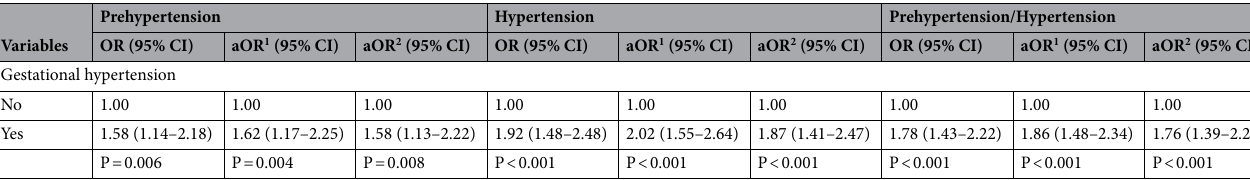
Table 2. Associations of maternal gestational hypertension with HBP in adolescent offspring (univariate and multivariate analyses). OR crude odds ratio, aOR 1 adjusted odds ratios for age and sex, aOR 2 adjusted odds ratios for age, sex, birth weight, adolescent BMI, and maternal pre/early pregnancy BMI, CI confidence interval.